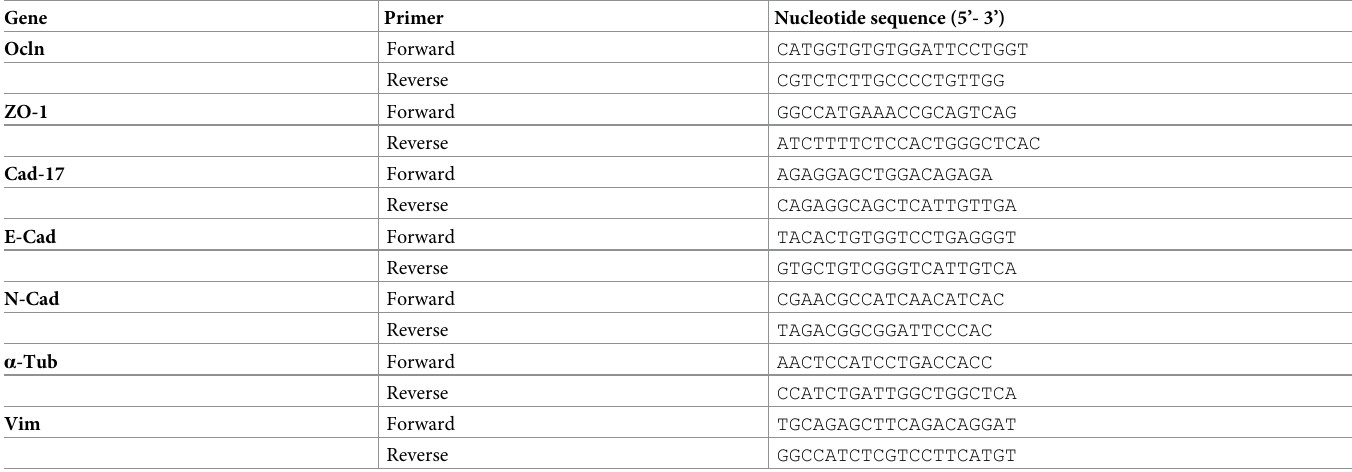
Table 3. Primers used for the molecular cloning of the target genes. Gene